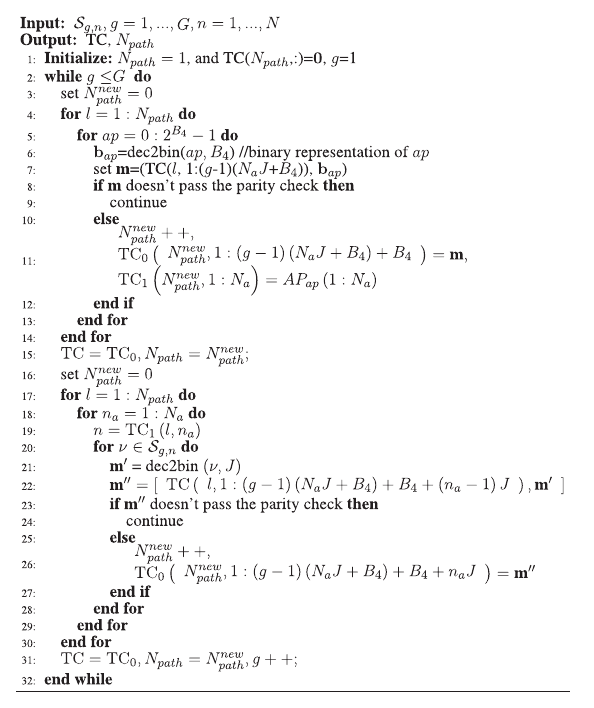
ALGORITHM 2 | Modi fi ed Outer Tree